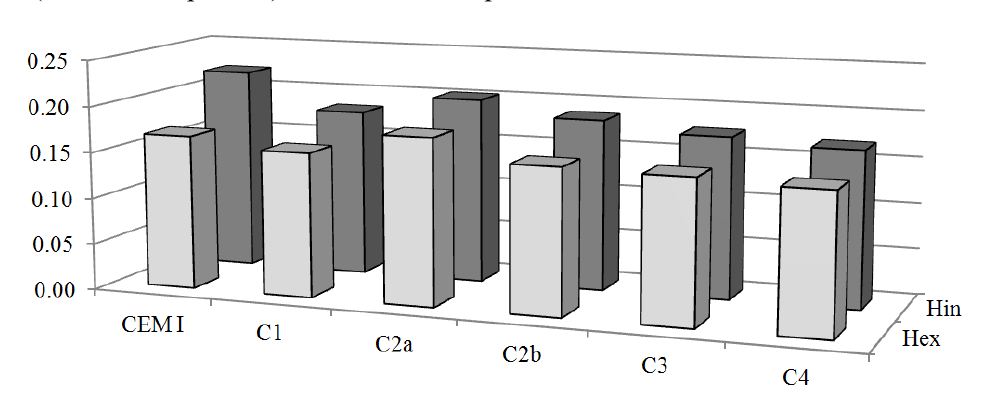
Figure 4. Comparison between the average values of internal and external hazard index of cement (used in composites) and cement